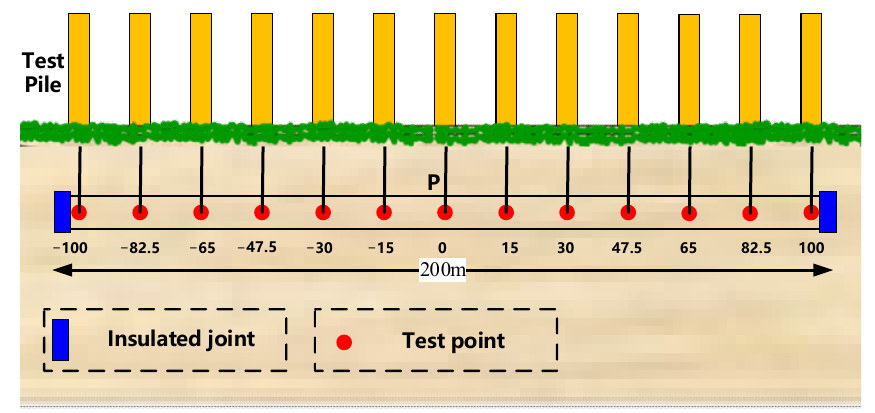
Figure 5. Test points layout along the pipeline.